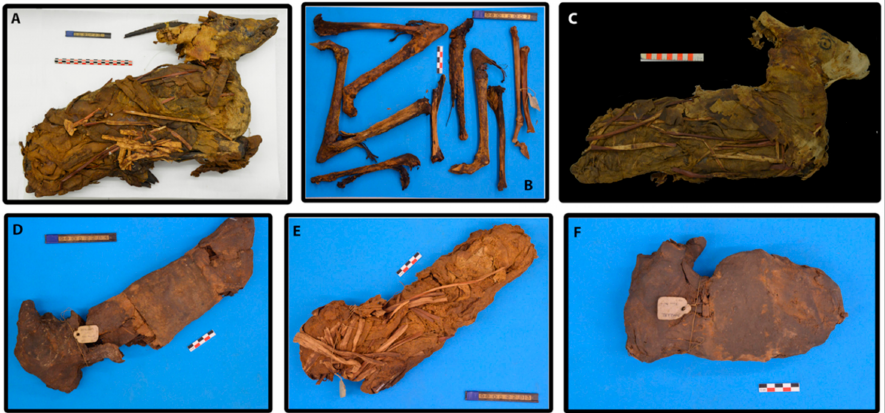
Figure 6. The set of six animal mummies from the Confluence Museum: ( A ) gazelle mummy, Inv 90001211; ( B ) gazelle mummy, Inv 90010003; ( C ) gazelle mummy, Inv 90001291; ( D ) gazelle mummy, Inv 90002284; ( E ) gazelle mummy, Inv 90002283; ( F ) gazelle mummy, Inv 90002282 (© Projet